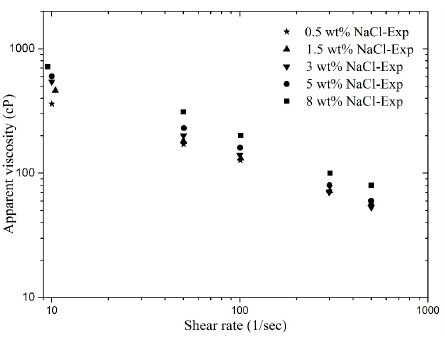
Figure 7. Effect of different salinity and shear rate on CO 2 foam apparent viscosity.